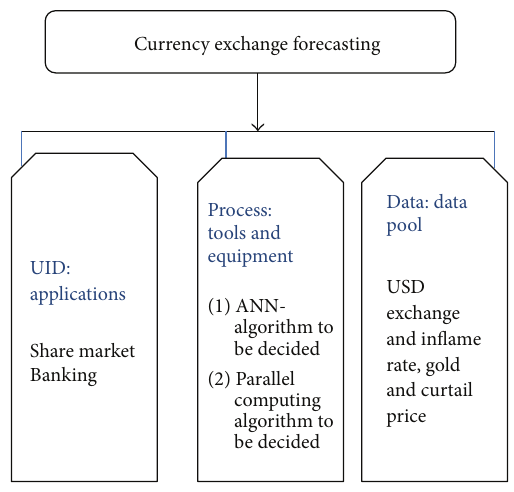
Figure 1: First-level design